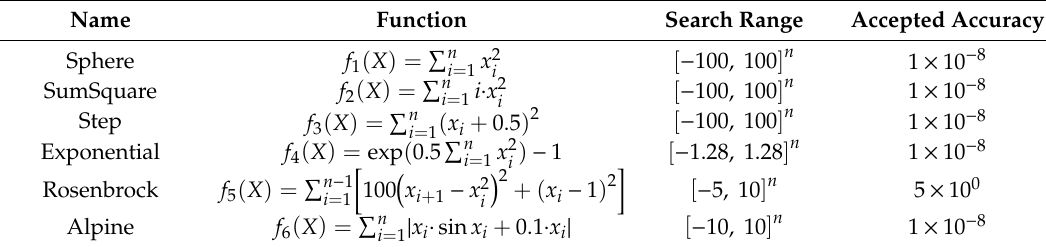
Table 1. Test suite with six benchmark functions.